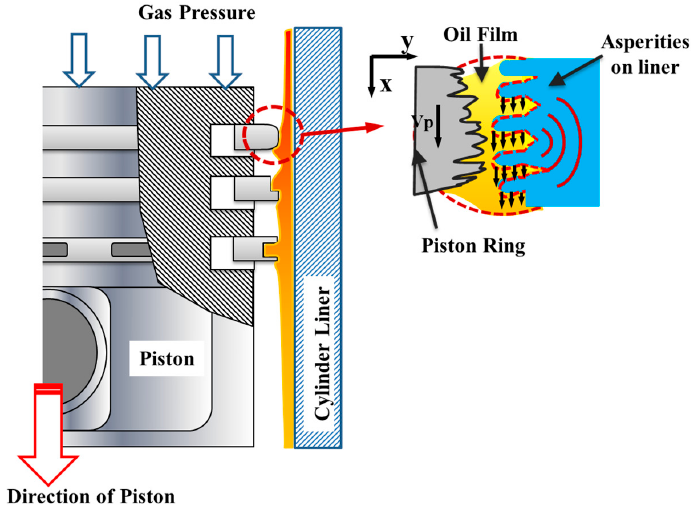
Figure 2. The schematic of asperity–fluid interaction between the piston ring and cylinder liner